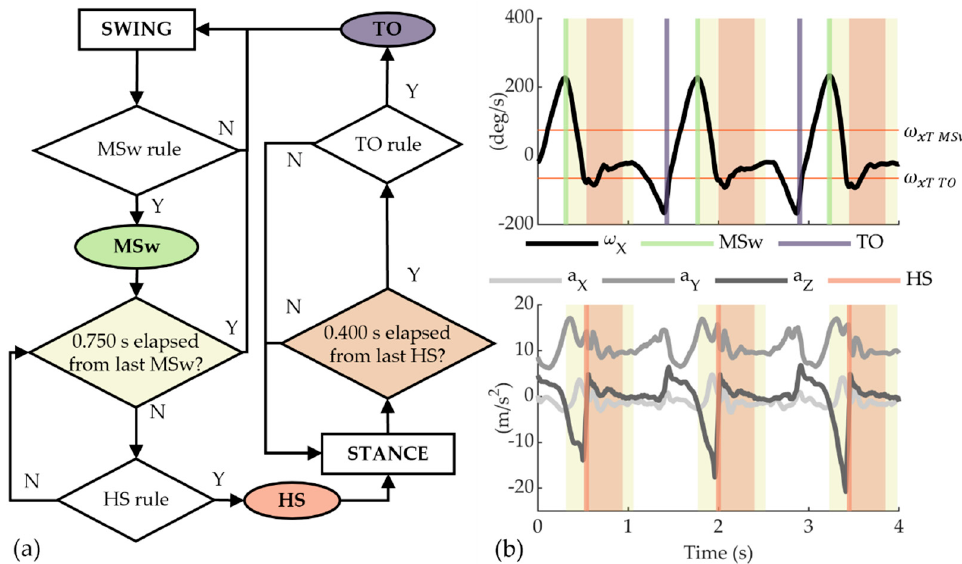
Figure 5. ( a ) Block diagram of the IMU-based algorithm for gait events detection; ( b ) Real-time gait events detection for an illustrative case. Vertical lines represent mid-swing (MSw), heel-strike (HS), and toe-off (TO) events. The yellow shaded area represents the observation window of 0.750 s after MSw, while the orange shaded one shows the idle period of 0.400 s after HS. Table 1. List of parameters implemented into the IMU-based algorithm.